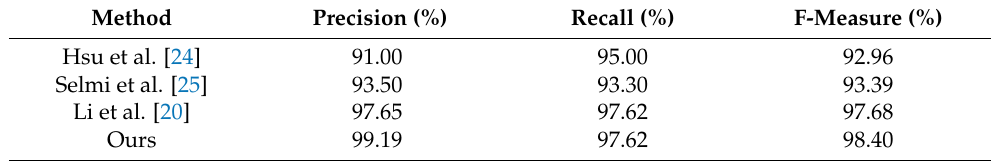
Table 4. Detection results on